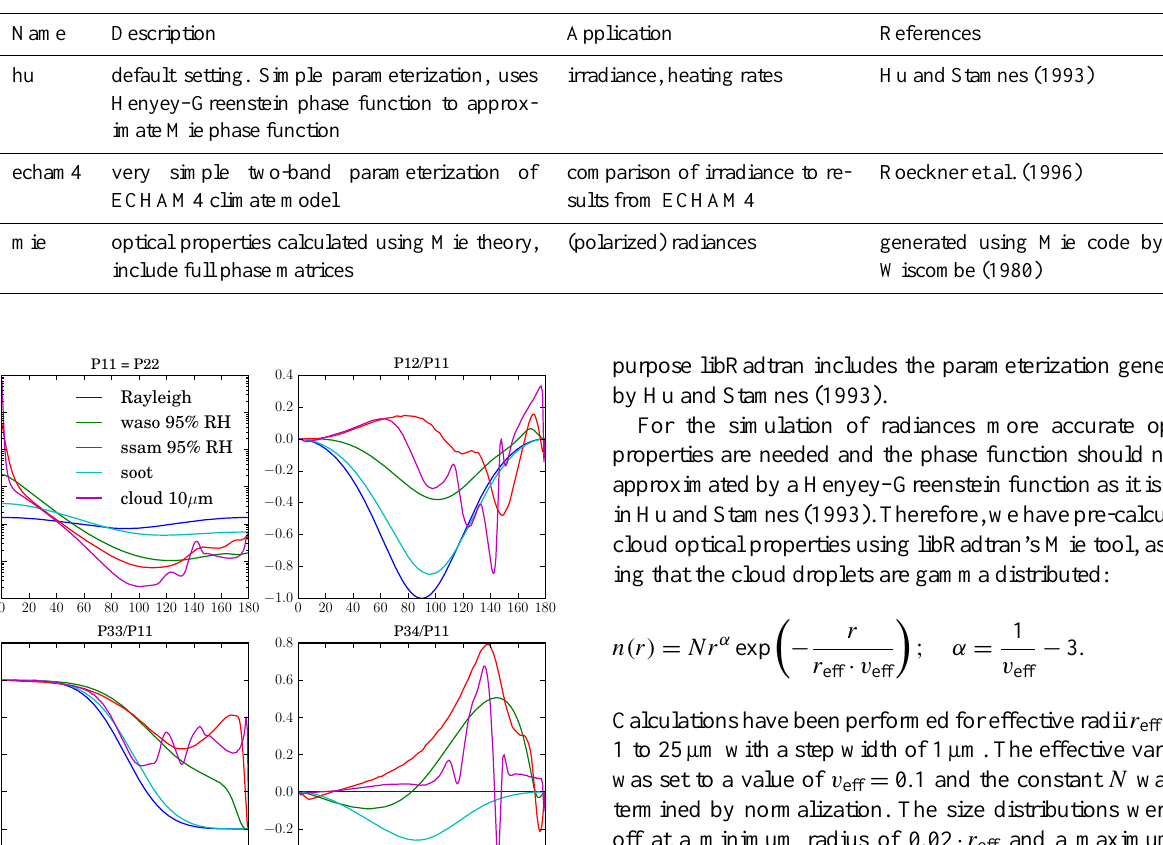
Table 4. Water clouds parameterizations in libRadtran.